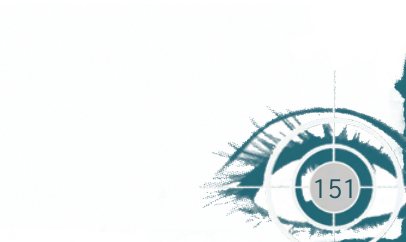
Figure 2: Shows the percentage of subjects that passed and failed the accommodative facility